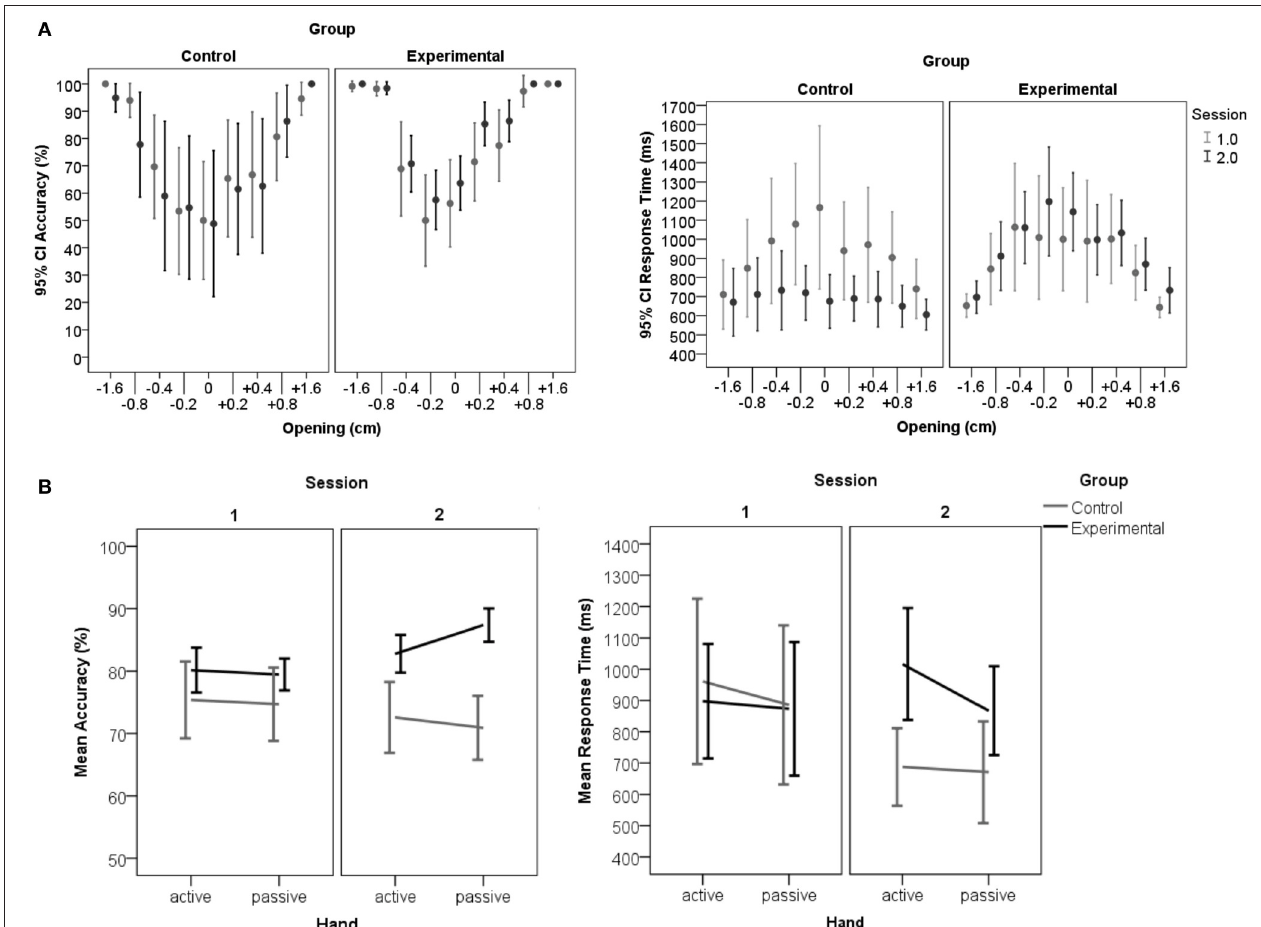
FIGURE 2 | Accuracy and RT in the aperture task. (A) Displays accuracy (left) and RT (right) distributions across openings per group and session. The graphs show the main effect of opening with judgment accuracy being lower (left) and judgments being slower (right) for those openings that are close to the physical constraints of the hands’ fit into the aperture (0cm) compared to more extreme deviations (e.g. ± 1.6cm). The Experimental-group significantly increased judgment performance in session 2, which is most obvious for openings close to the hands’constraints. For trials ranging close to the constraints (openings: − 0.2 to + 0.4) the Control-group initiated responses faster in the second session than participants who received feedback (Experimental-group). Error-bars represent 95% confidence intervals. (B) Displays accuracy and response times per session, group and hand. Participants indicated responses with one designated hand (active hand), the other hand is called the passive hand. Left: In the second session the Experimental-group showed overall increased accuracy compared to the Control-group. Within the Experimental-group responses are significantly more accurate for the passive hand, which was judged subsequent to the learning experience with the active hand. The accuracy data implies that the improved criterion was transferred to the following passive hand trials. Right: Slower RTs for judgments when experiencing the active hand in the opening may reflect a reevaluation taking place during the feedback trials. Generally, faster responses in the second session within the Control-group suggest that this group based decisions on a judgment criterion settled in the first session. Error-bars represent 95% confidence intervals.